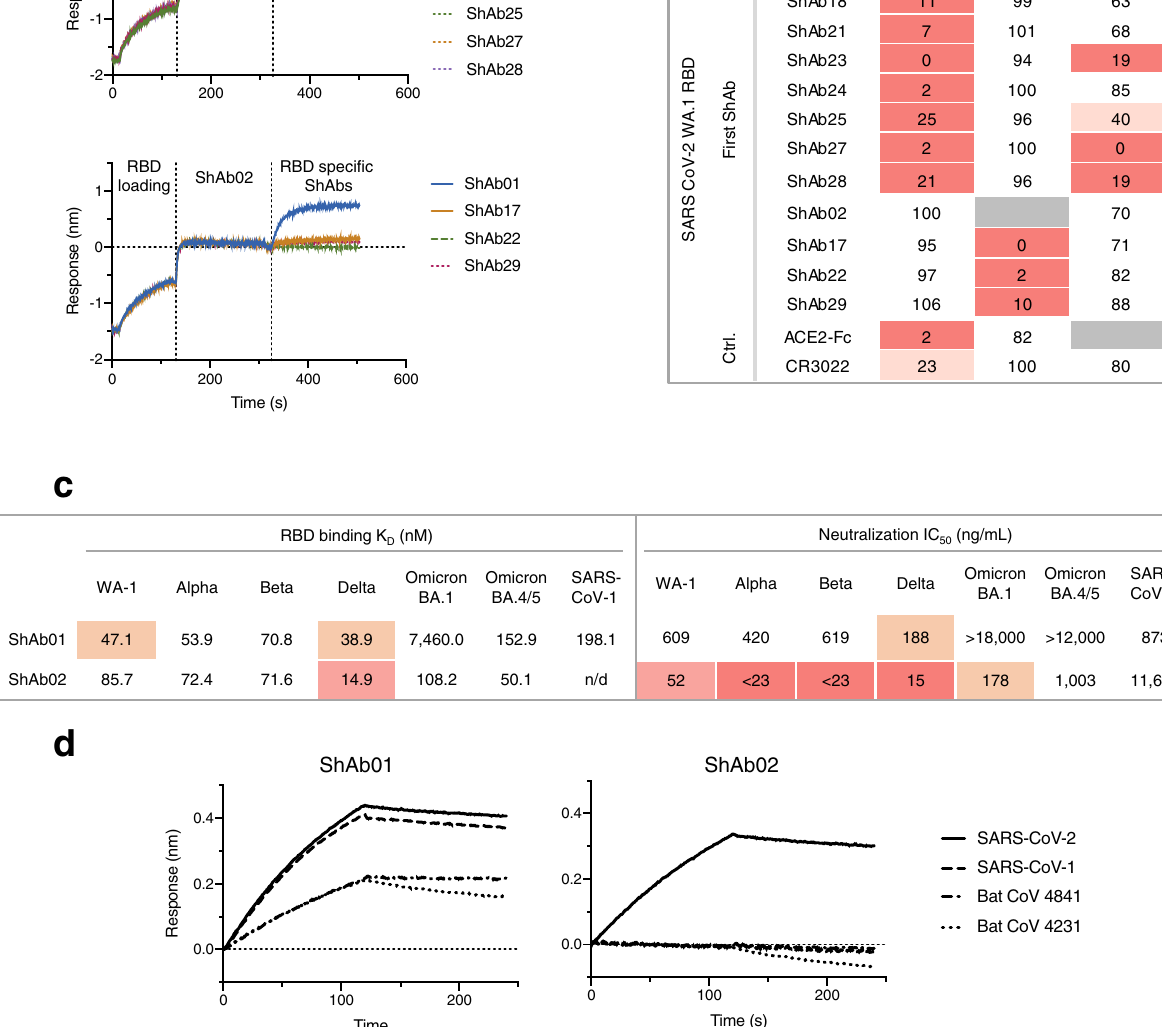
from strong competition (0 – 33%), to reduced competition (>50%). Competition groups are indicated by black boxes. Human ACE2-Fc and CR3022 were used as controls. c RBD kinetic binding constants, and neutralization IC 50 titers of SARS- CoV-2 viral VoC and SARS-CoV-1 pseudoviruses by ShAb01 and ShAb02. n/d indi- catesnobindingwasdetected. d ShAb01andShAb02bindingassaysperformedby BLIwithimmobilizedShAbsandSARS-CoV-1RBDandSARS-CoV-2RBD,orclade1b bat sarbecovirus trimeric S molecules in solution. Source data are provided as a Source Data fi